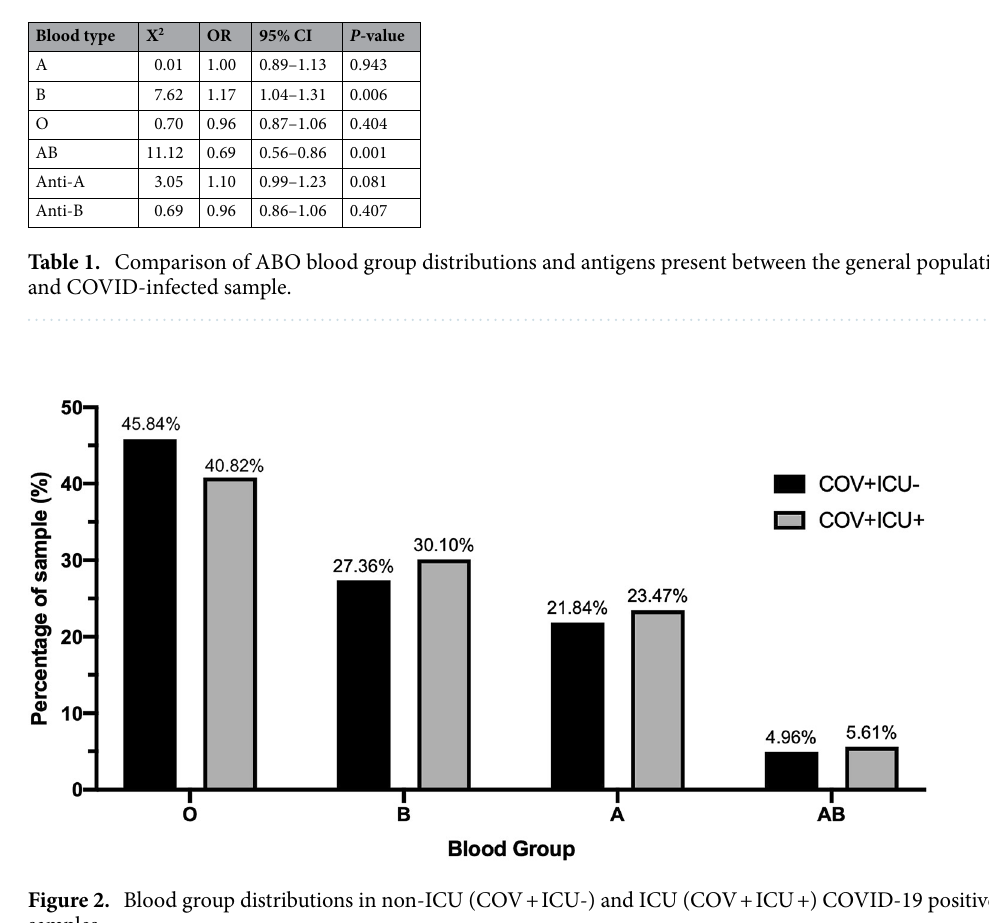
Figure 2. Blood group distributions in non-ICU (COV + ICU-) and ICU (COV + ICU +) COVID-19 positive